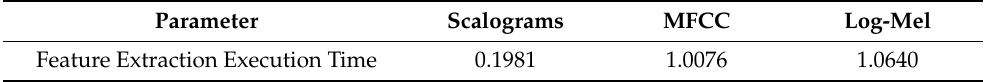
Table 4. Average execution time for inference (in s).